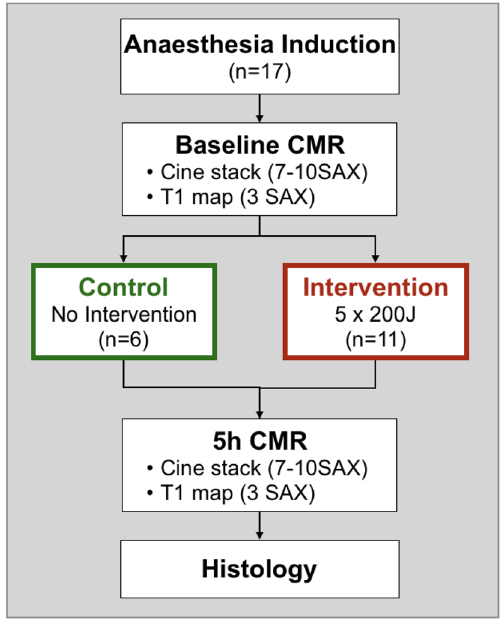
Figure 2. Study protocol. CMR cardiovascular magnetic resonance exam, SAX short axis